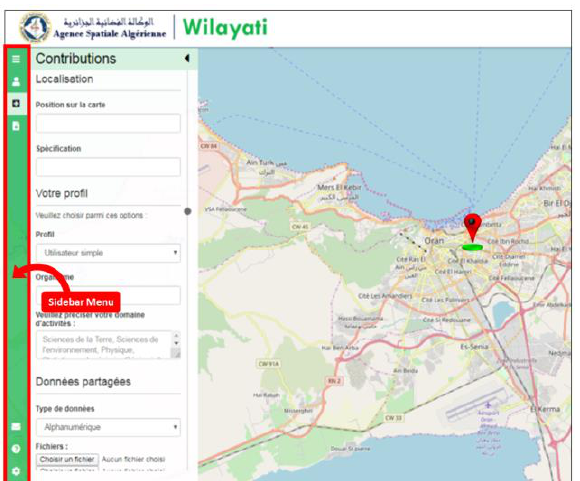
Figure 7 . Contribution form based on the selected location on the map.